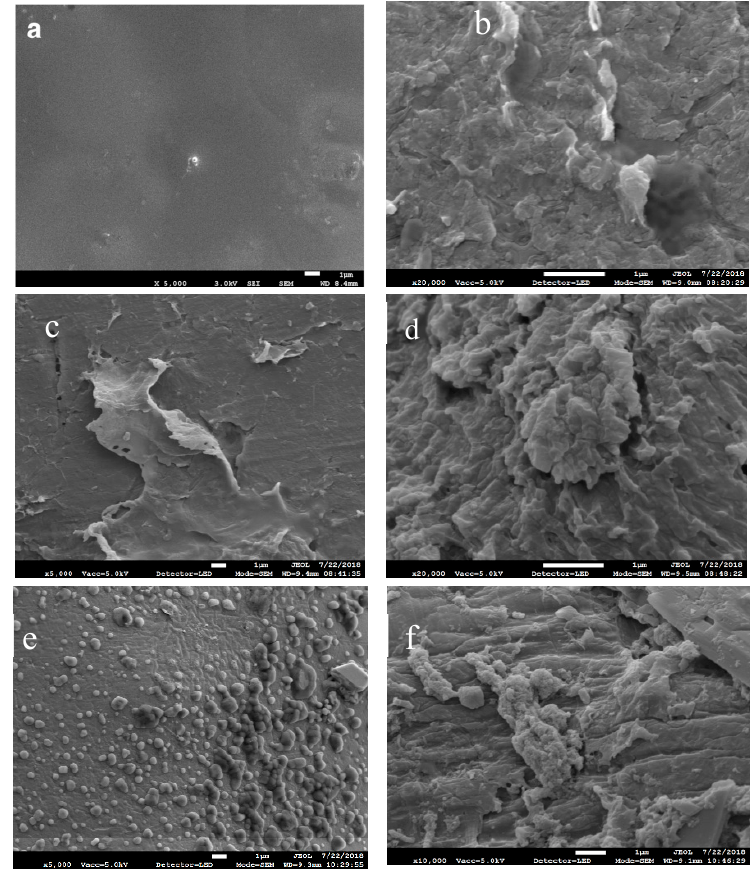
Figure 3. Scanning electron microscopy (SEM) images of membranes: ( a ) SPEEK–75/AIL; ( b ) SPEEK–75/AIL/SiO 2 –5; ( c ) SPEEK–75/AIL/SiO 2 –8; ( d ) SPEEK–75/AIL/SiO 2 –10; ( e ) SPEEK–75/AIL/SiO 2 –13; ( f ) SPEEK − 75/AIL/SiO 2 − 17.